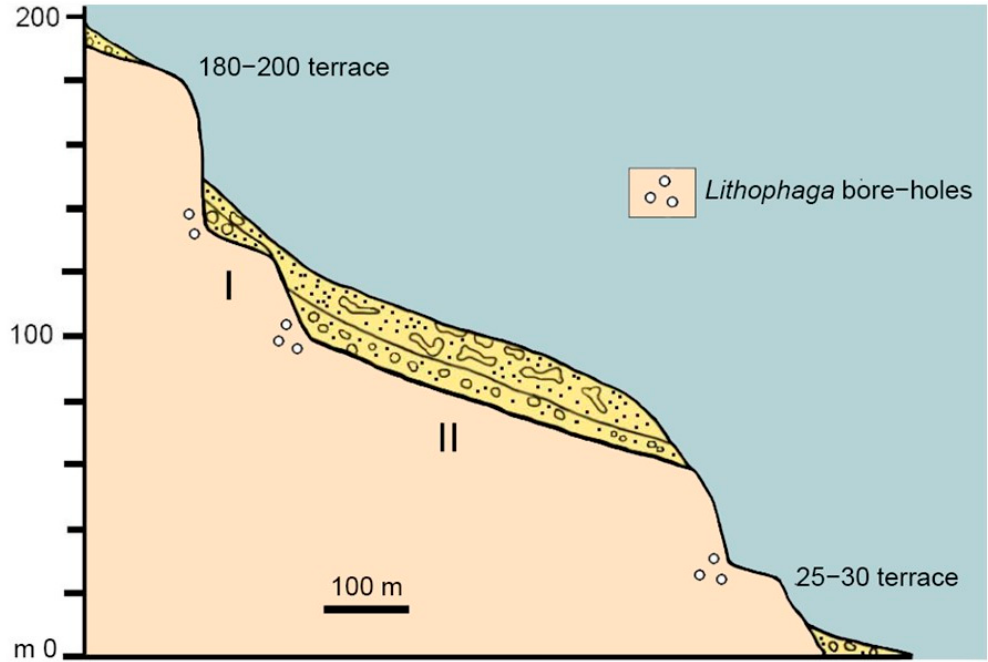
Figure 3. Schematic geological profile of the “PO” polycyclic terrace from northeastern Sicily. I- abrasion platform at 131 m a.s.l; II MIS 5e abrasions platform at 60–90 m. The older terrace located at 200 m and the younger one located at 25–30 m a.s.l. are also shown (from [6], modified).